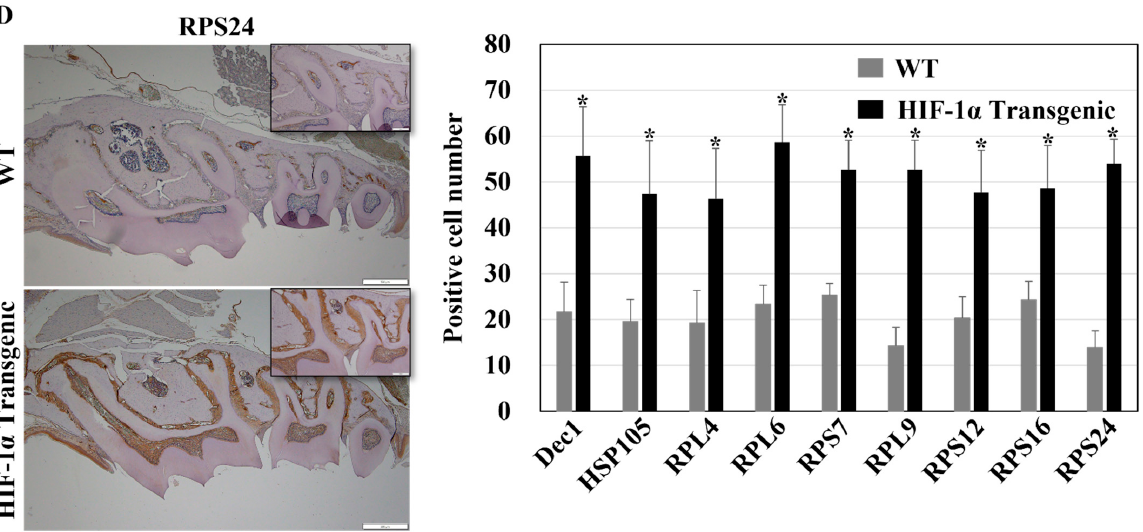
Figure 5. HIF-1 α facilitates Dec1 expression and ribosomal protein regulation in mouse tissues. ( A – D ) Immunohistochemical staining showing the expression levels of Dec1, HSP105, and ribosomal proteins in the PDL of WT and HIF-1 α transgenic mice. Scale bars = 500 μ m. All results are representative of at least three independent experiments. The data shown represent means ± SD; * p < 0.05.